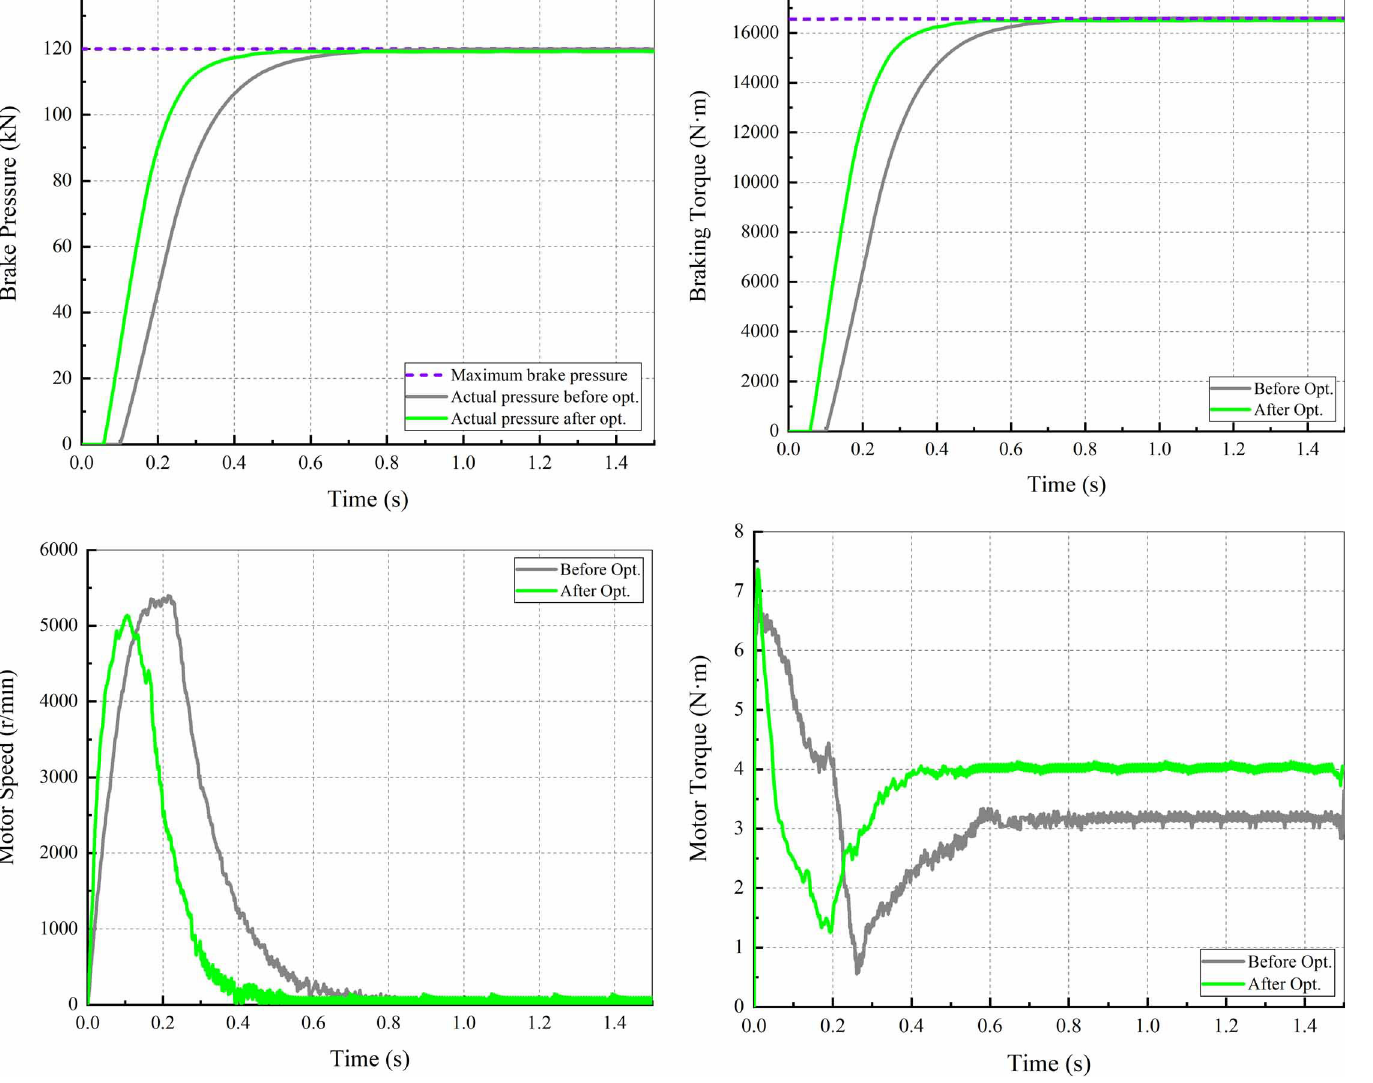
Fig 15. Response curves of the EMB. (a) Braking pressure; (b) Braking torque; (c) Motor speed; (d) Motor torque.